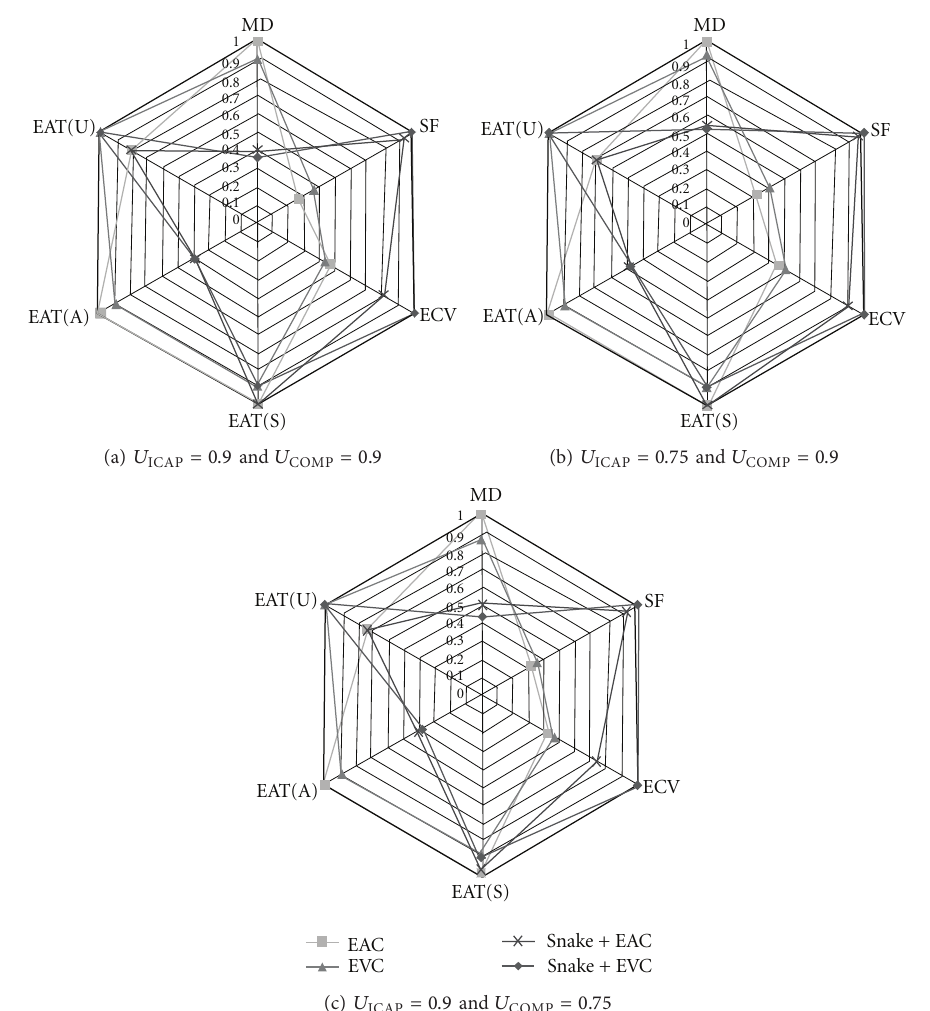
Figure 18: Performance on a realistic RC simulation scenario when using the Snake approach. EAT(U) refers to the EAD updating time, EAT(A) refers to the time needed for making the allocation decisions, and EAT(S) is the time needed for making the scheduling